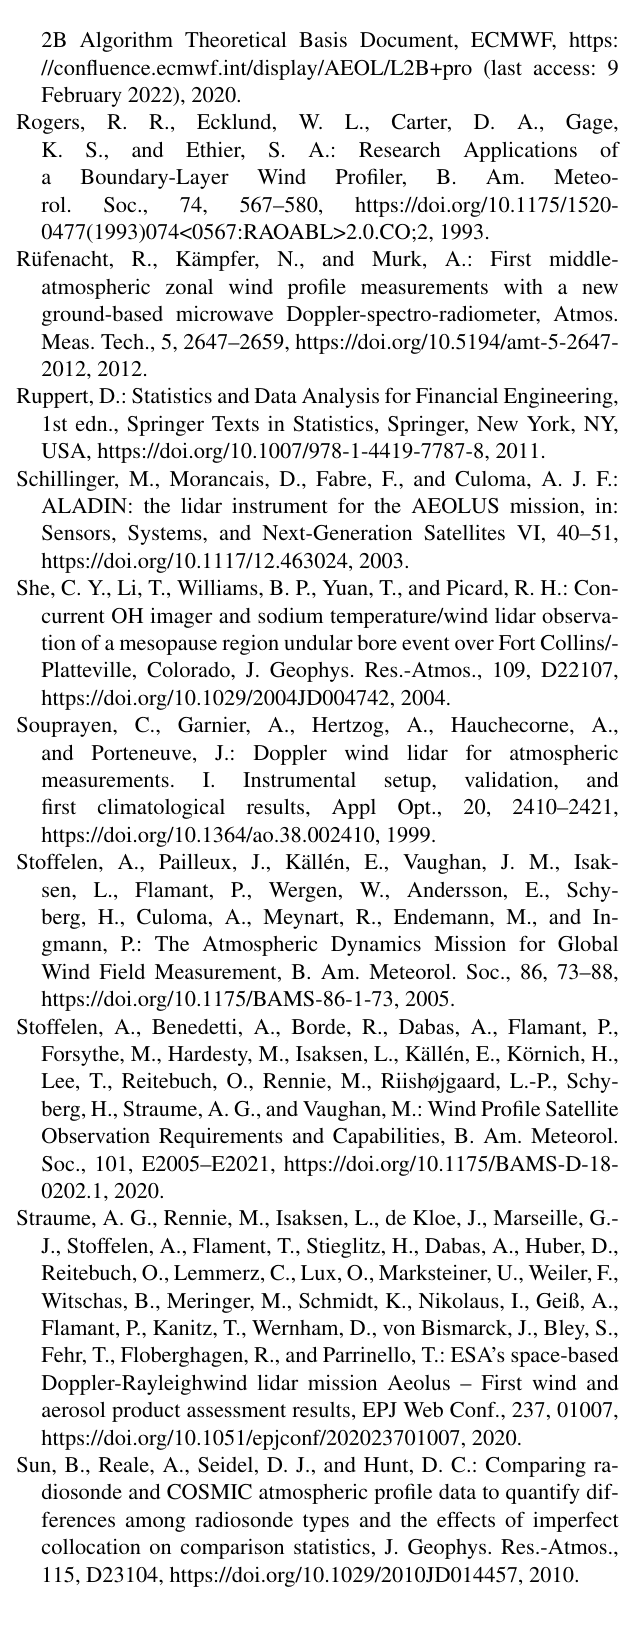
2B Algorithm Theoretical Basis Document, ECMWF,